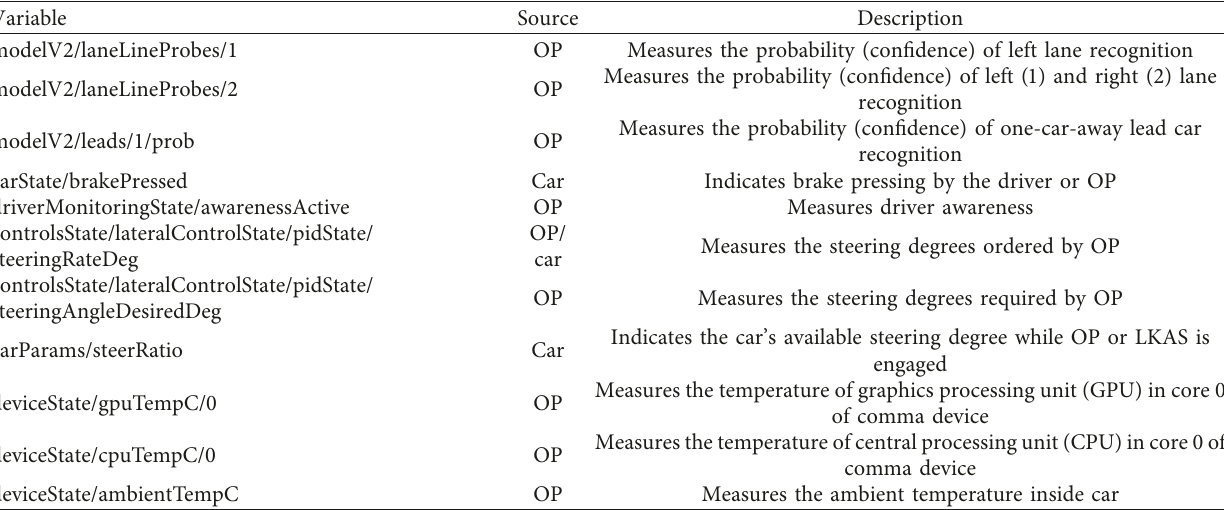
Table 5: Used OP